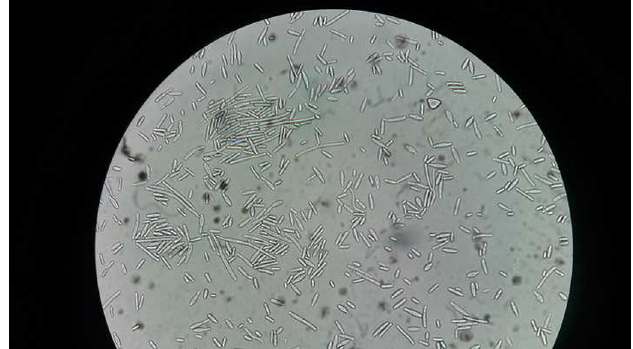
Fig. 3. Microscopic image of Saprochaete capitata colony ( (cid:1) 400). Wet-mount preparations showing arthroconidia and annelloconidia.